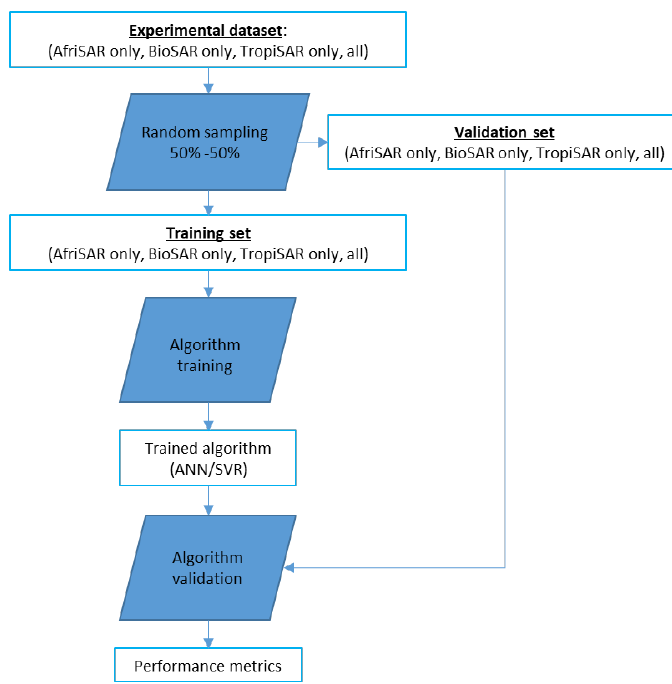
Figure 1. Generation of training and validation datasets.